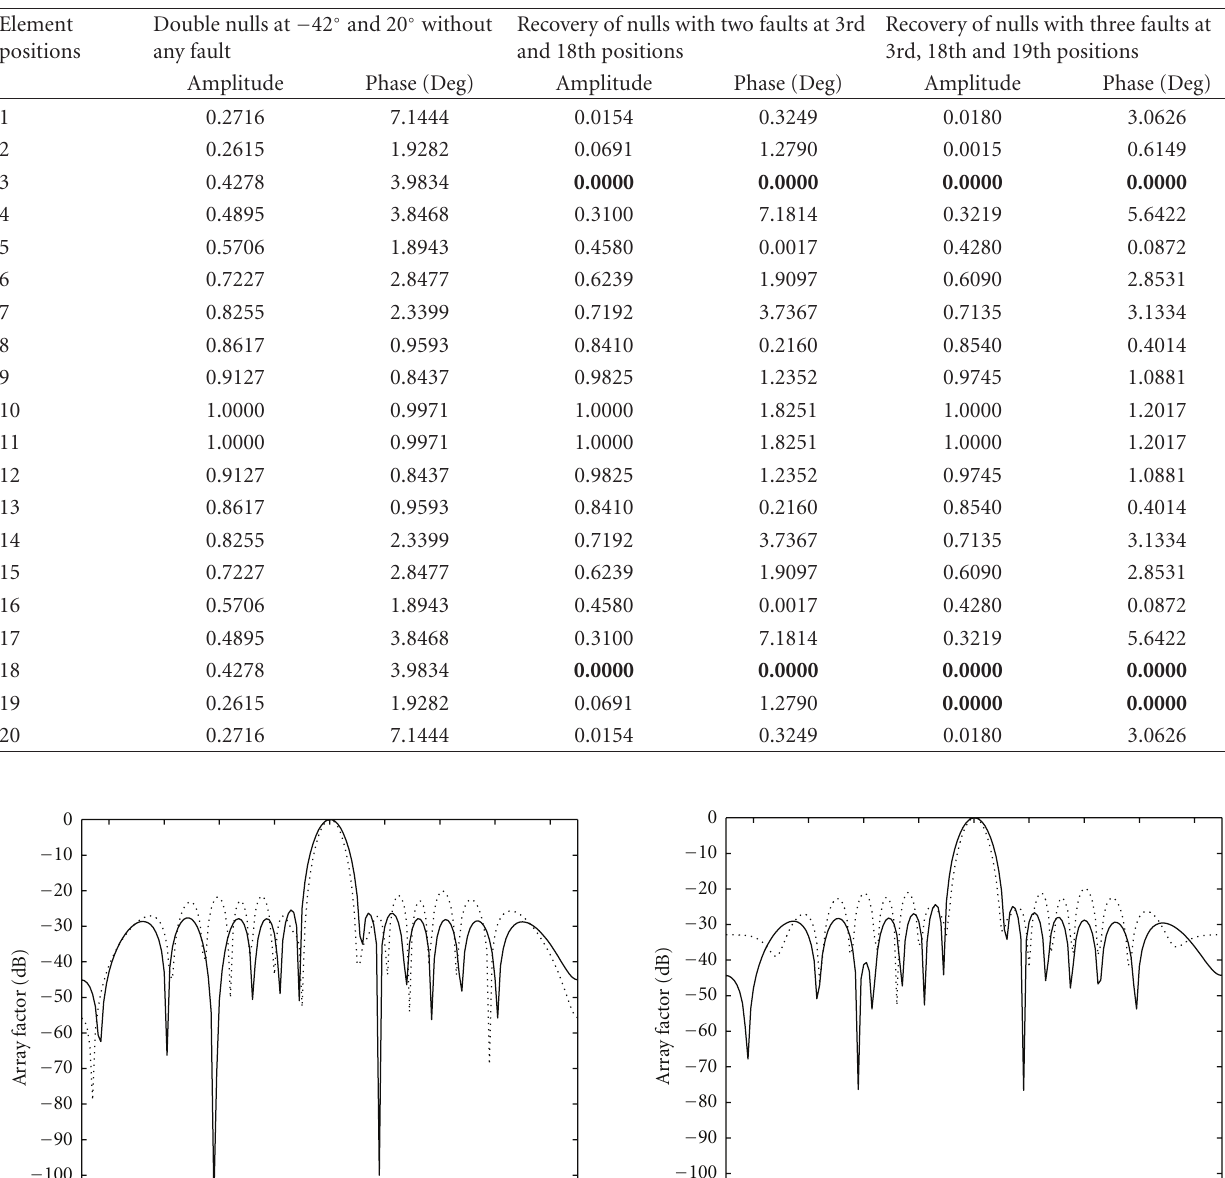
Table 3: Element excitations corresponding to Case 2.